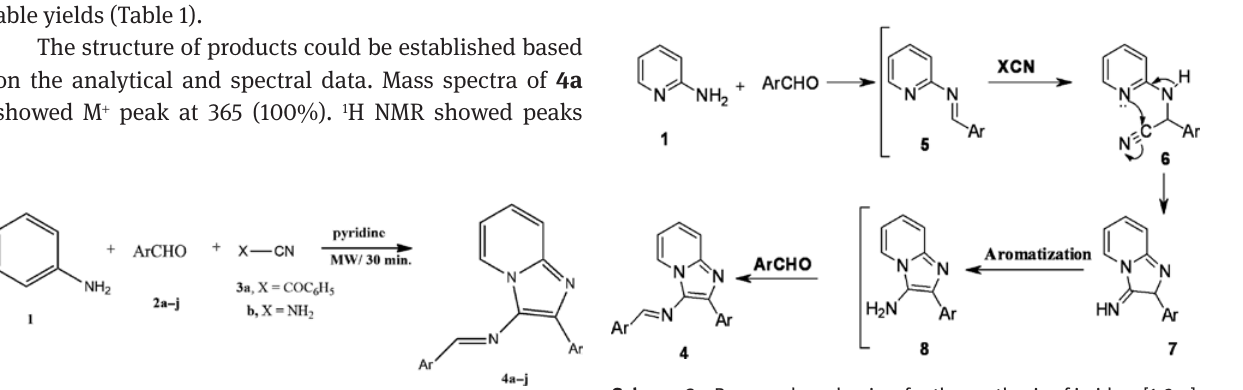
Scheme 2: Proposed mechanism for the synthesis of